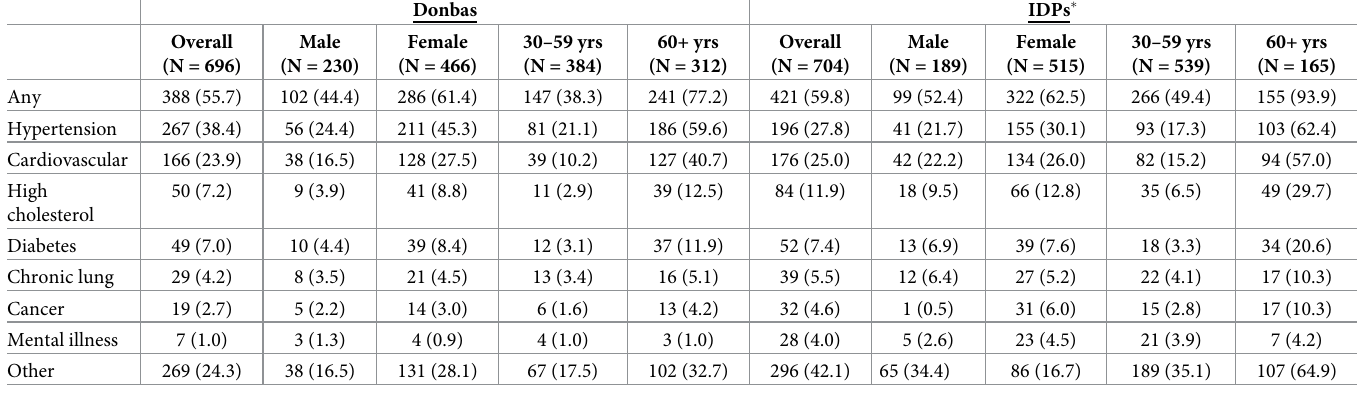
Table 2. Noncommunicable disease prevalence among conflict-affected adults in Ukraine, by sex and